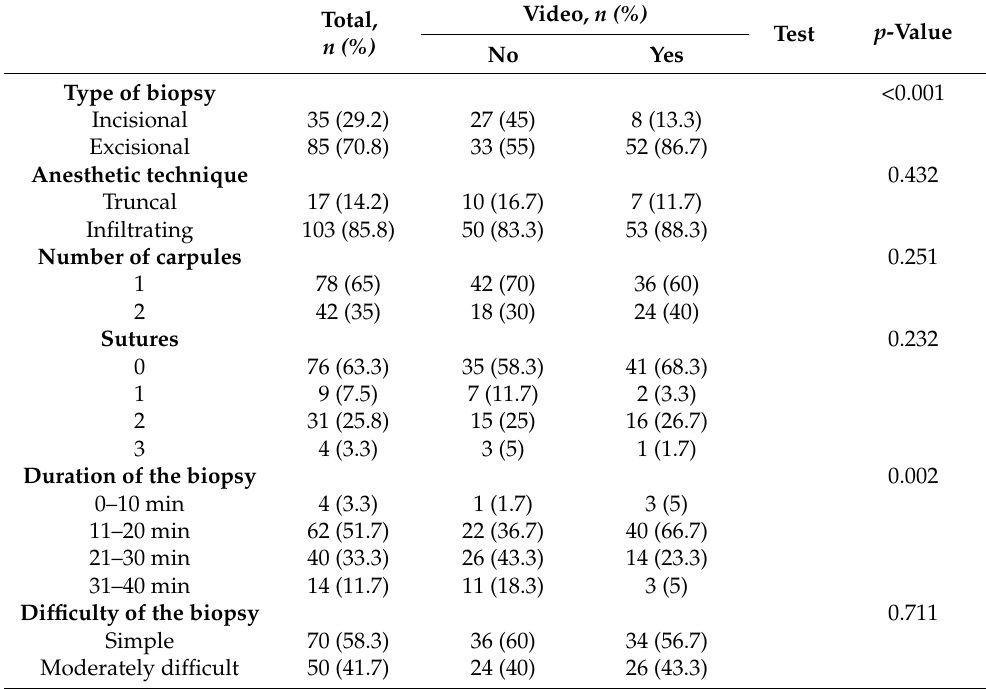
Table 2. Description and comparison of the oral biopsy parameters.